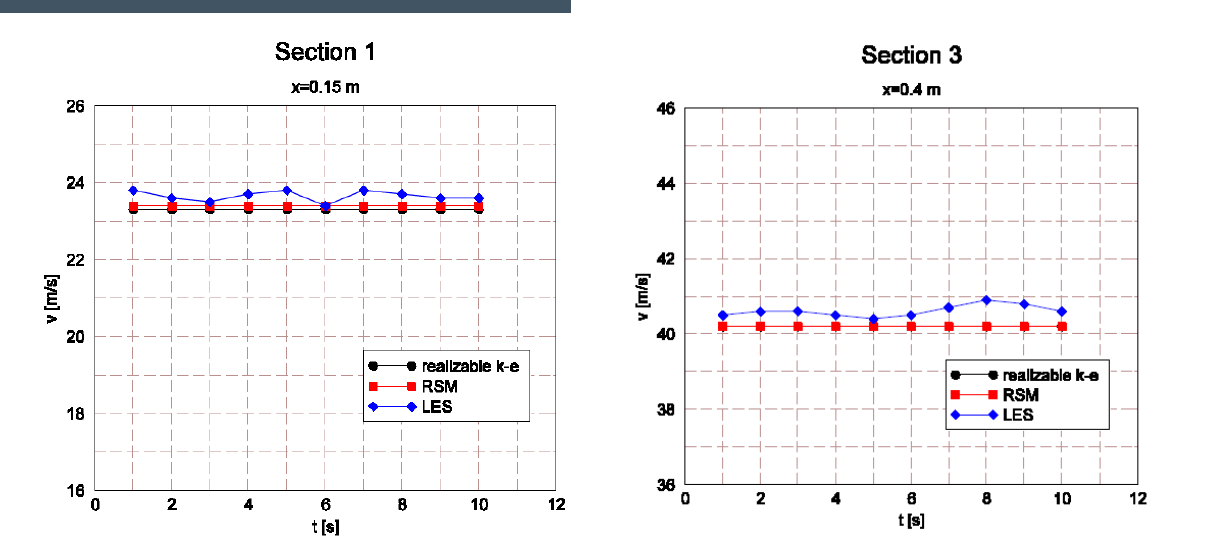
by the RSM model. Meanwhile the values obtained with the LES model show greater instability, with maximum deviation of 4.6 % compared to the realizable k-ε model.